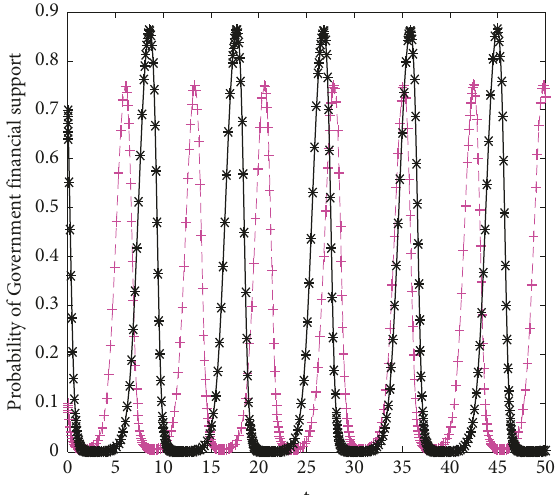
Figure 5: The evolution path of government financial support under the static incentives mechanism and penalties mechanism.